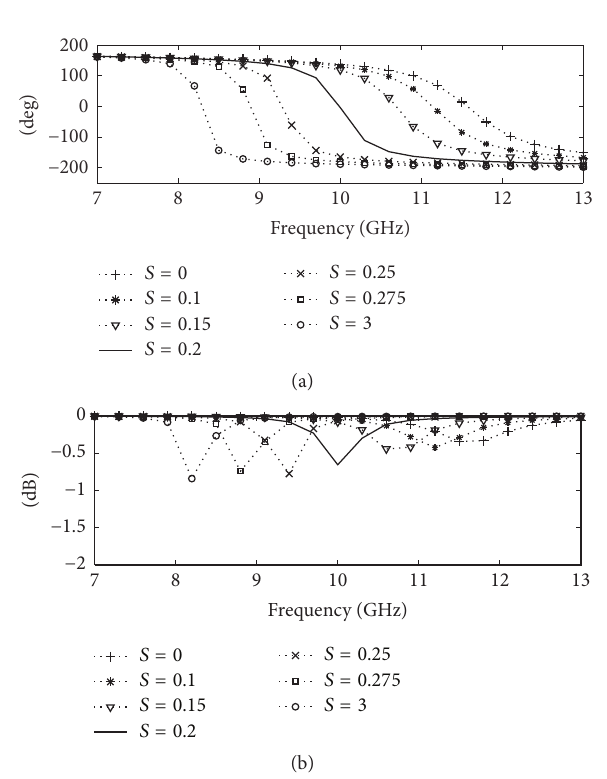
Figure 12: (a) Phase and (b) amplitude of the simulated reflection coefficient versus frequency for different value of the scaling factor 𝑆 (1st iteration fractal unit cell with 𝐿 = 7.82 mm and Δ𝑥 × Δ𝑦 = × 0.4𝜆 0.4𝜆 0 0 ).